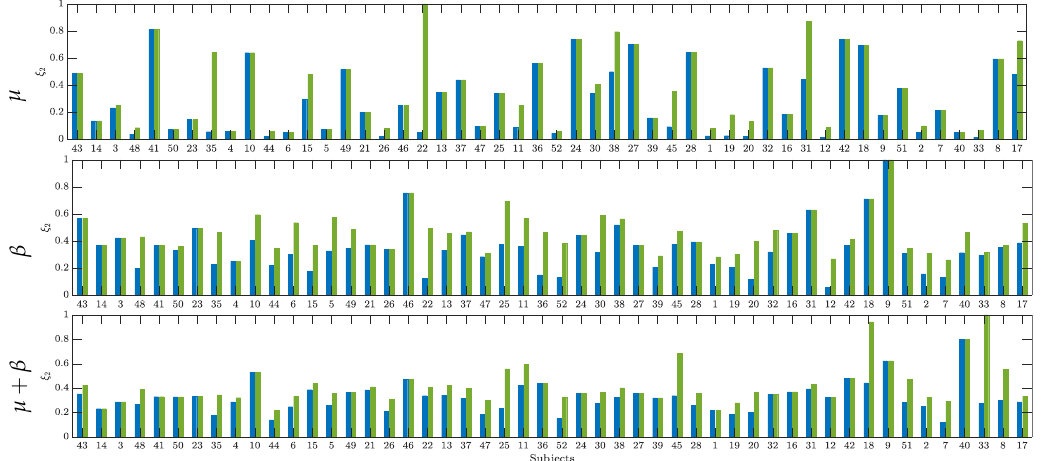
Figure 7. Individual values of initial training synchronization ξ 2 computed within subband combinations: µ , β , µ + β .